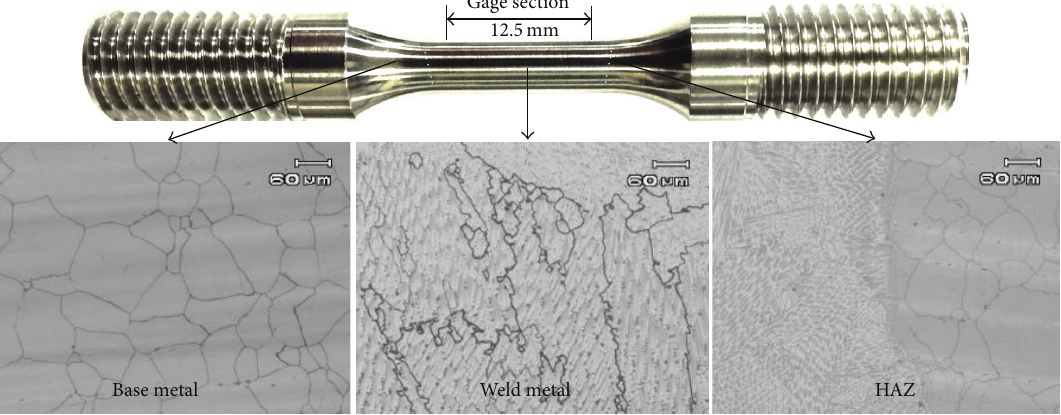
Figure 2: Microstructures with respect to LCF welded